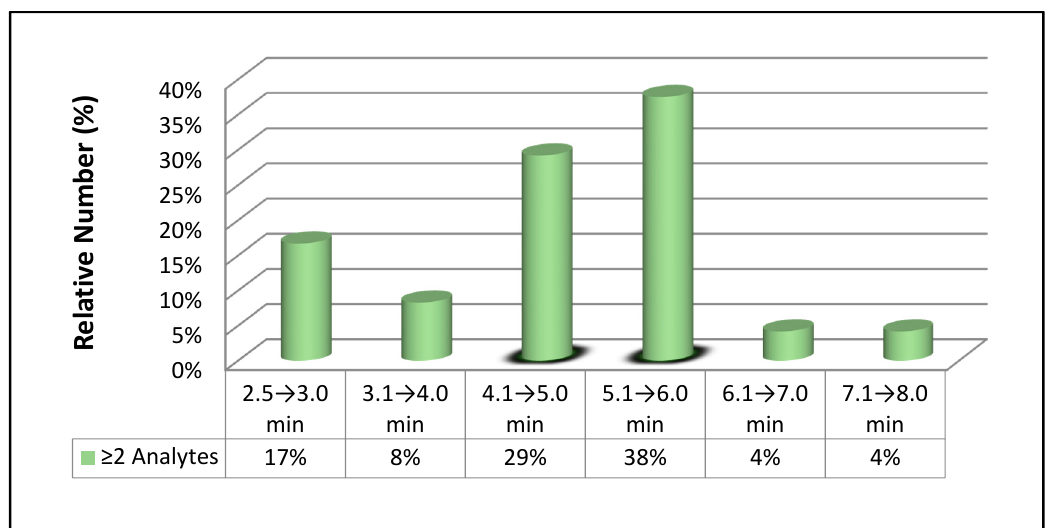
Figure 3. Run time (min) for determination of 1 analyte.